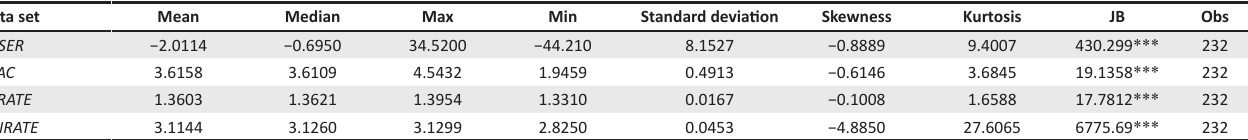
TABLE 1: Descriptive statistics of data set.